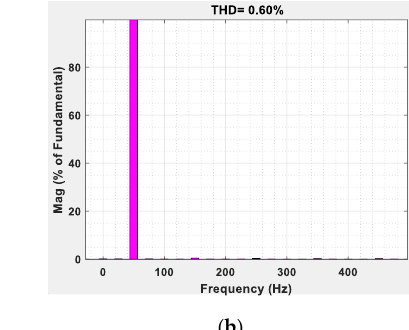
Figure 13. FFT spectrum of the output voltage without output voltage regulation capabilities for output frequency requirement: ( a ) one-half; ( b ) one-third; ( c ) one-fourth.